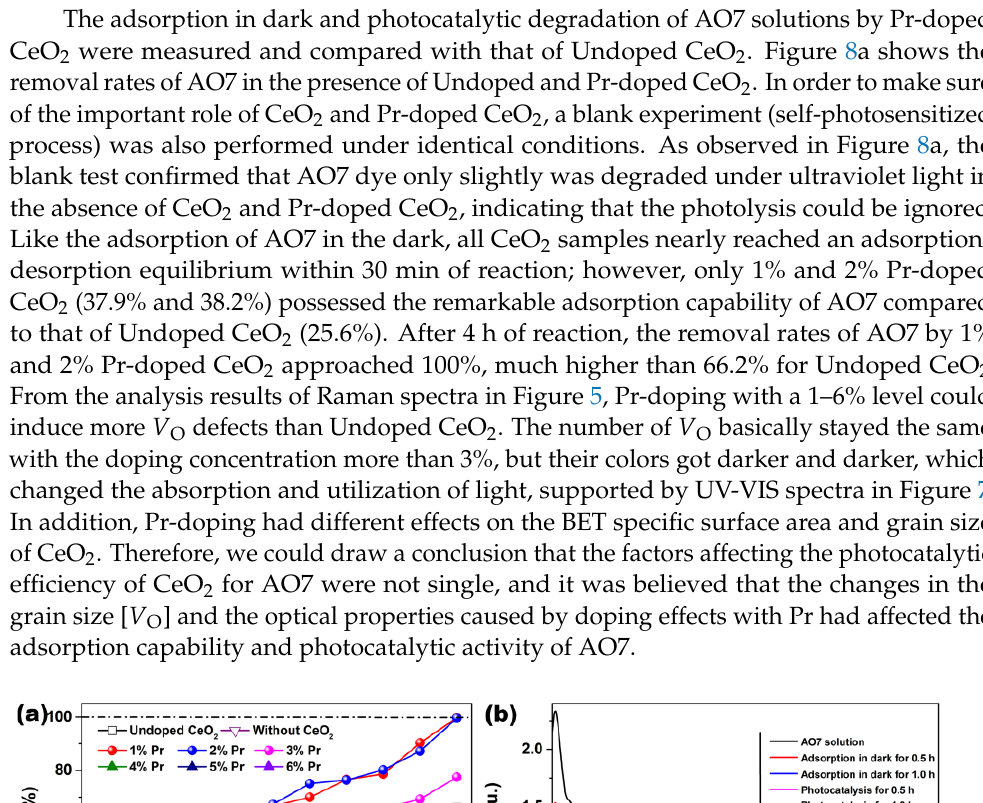
Figure 7. Reflectance spectra and photographs of Undoped CeO 2 and Pr−doped CeO 2 with different Pr contents.